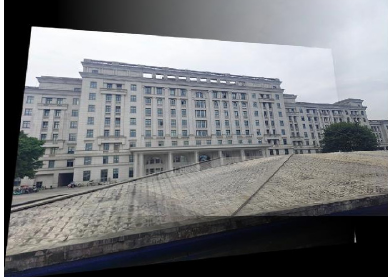
Figure 13. The stitched image generated by using M ac .